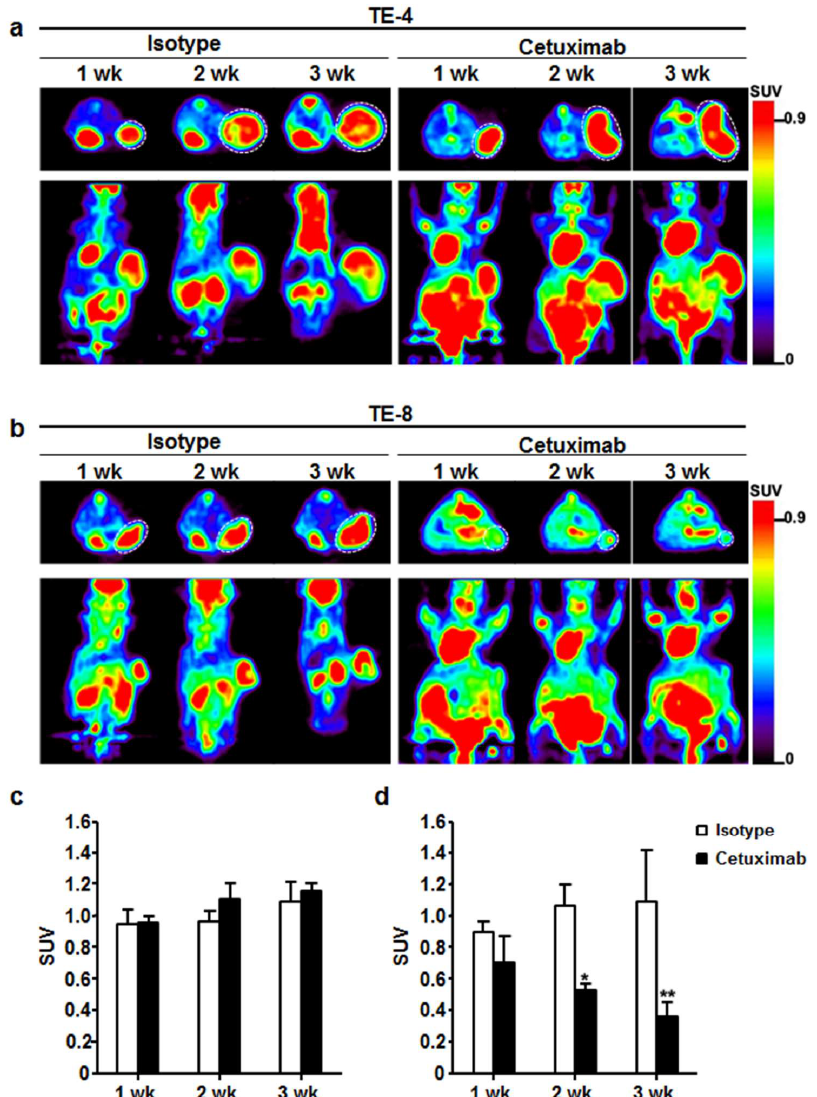
Figure 6. Therapeutic response monitoring with cetuximab treatment using 18 F-FDG-PET imaging. ( a ) For 3 weeks, 18 F-FDG uptake was maintained or slightly increased in TE-4 tumor regardless of treatment. ( b ) 18 F-FDG uptake gradually decreased for 3 weeks in TE-8 tumors by cetuximab treatment. On the other hand, 18 F-FDG accumulation gradually increased with isotype treatment in TE-8 tumors. ( c ) and ( d ) Quantitative indices of 18 F-FDG uptake in TE-4 and TE-8 tumor